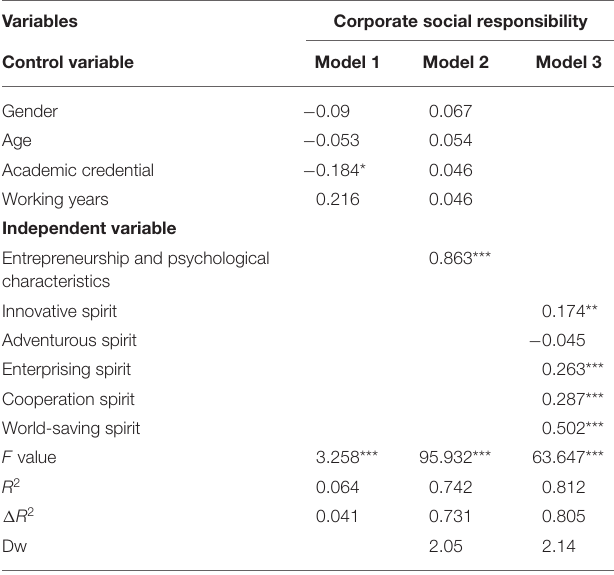
TABLE 2 | Regression analysis of entrepreneurship and psychological characteristics on corporate social responsibility.